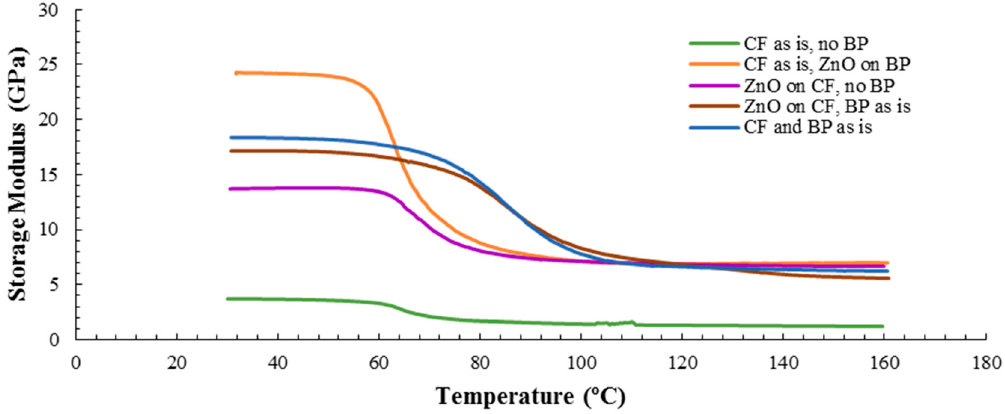
Figure 10. The variation of storage modulus with temperature for the various composites configurations.